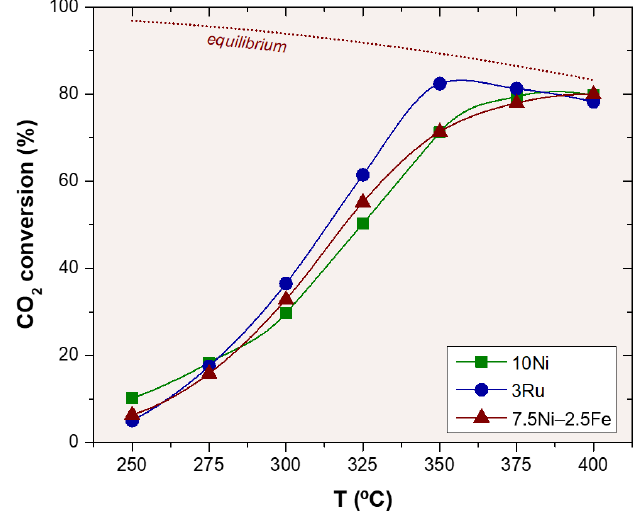
Figure 4. CO 2 conversion as a function of temperature and catalyst tested for a feed without methane (‘W/O CH 4 ′ ). Operating conditions (Table 2): q 0 = 250 STPmL·min −1 , H 2 :CO 2 = 4:1, and WHSV = 30 × 10 3 (STPmL·g cat −1 ·h −1 ). Lines are only for visual help. Dashed curve represents thermodynamic equilibrium.